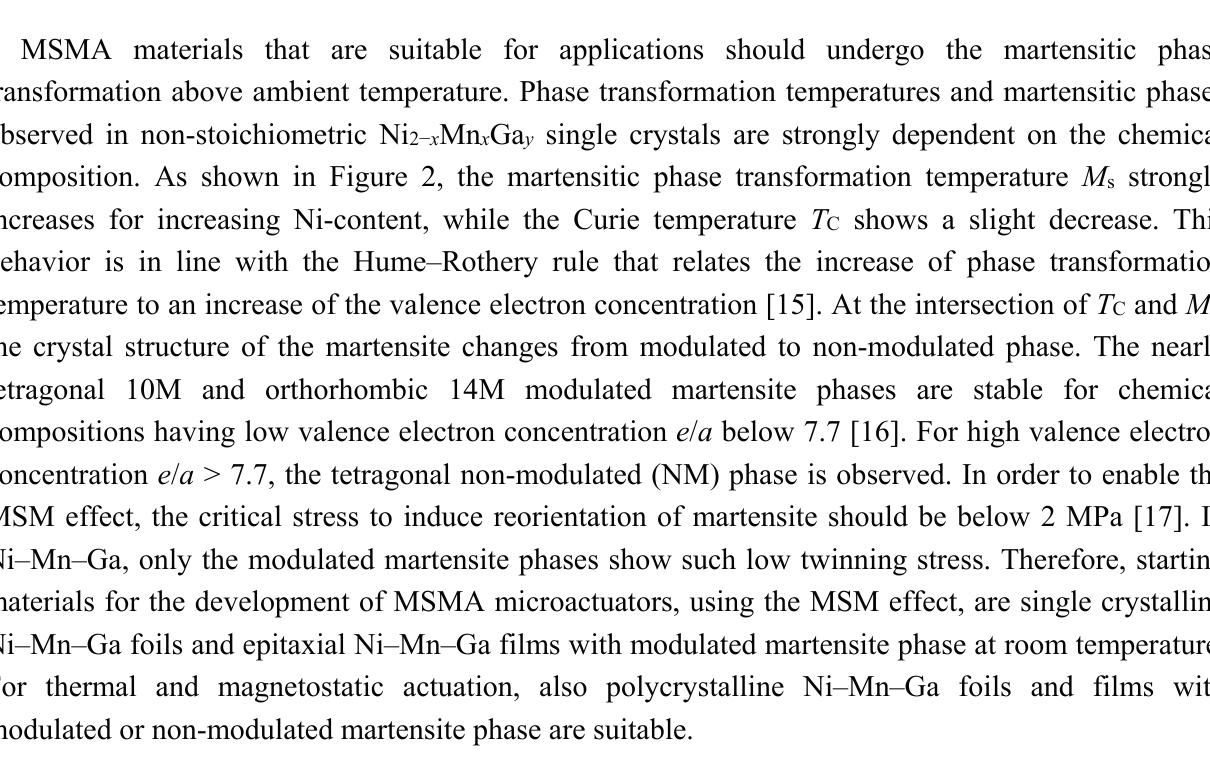
Figure 2. Start temperature of martensitic transformation M s and Curie temperature T C as a function of Ni content for Ni–Mn–Ga bulk and thin film materials. Reprinted with permission from [18], copyright 2000 IOS